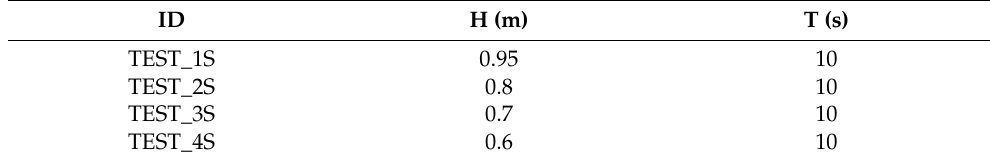
Table 6. Wave characteristics of additional tests performed with SWASH. ID H (m) T (s)